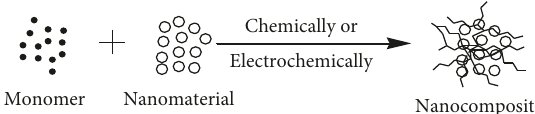
Figure 7: In situ nanocomposite synthesis